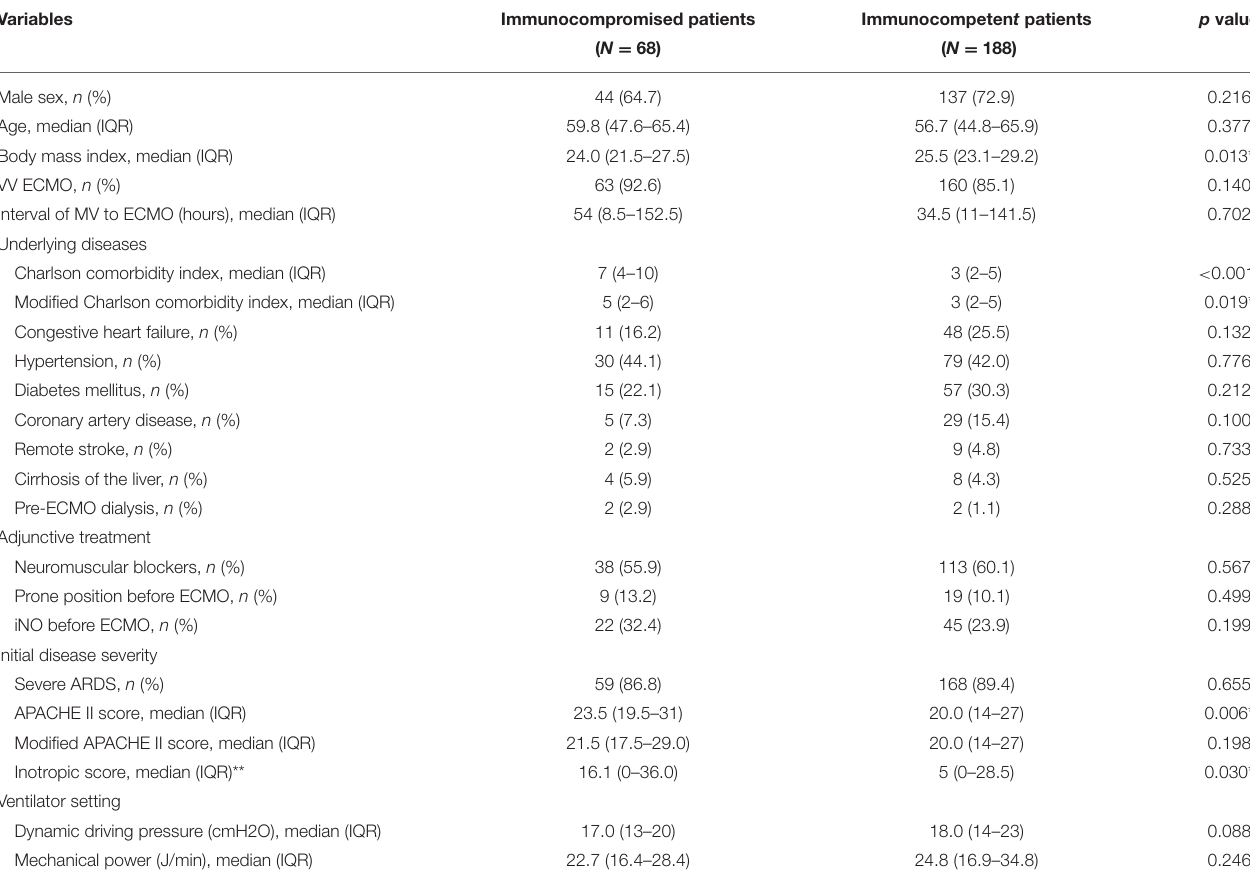
TABLE 1 | Baseline characteristics of the patients grouped by immune status.